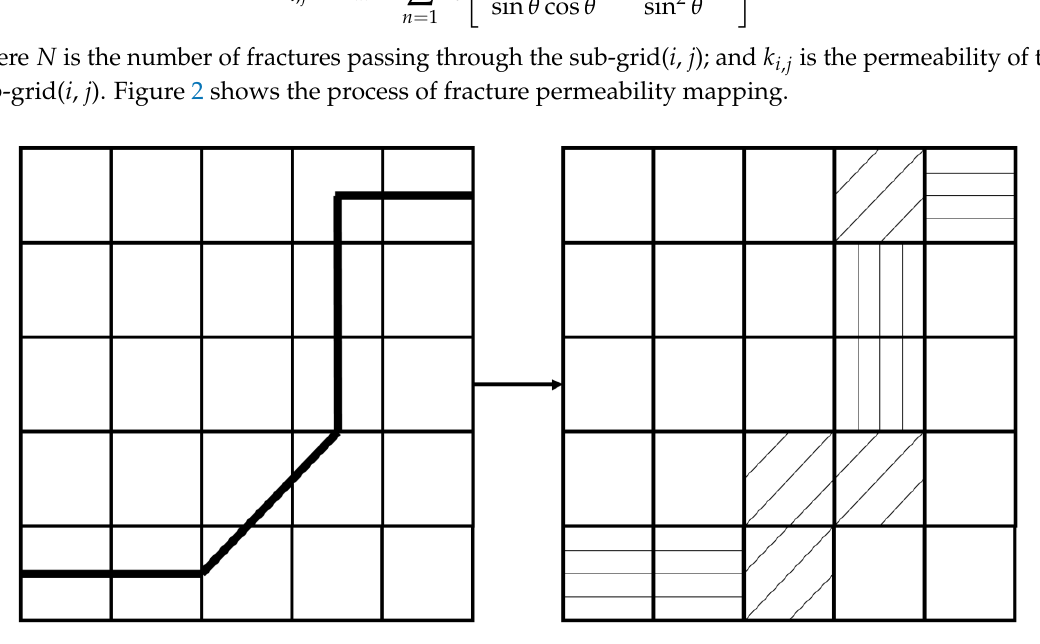
Figure 2. The schematic diagram of permeability mapping.